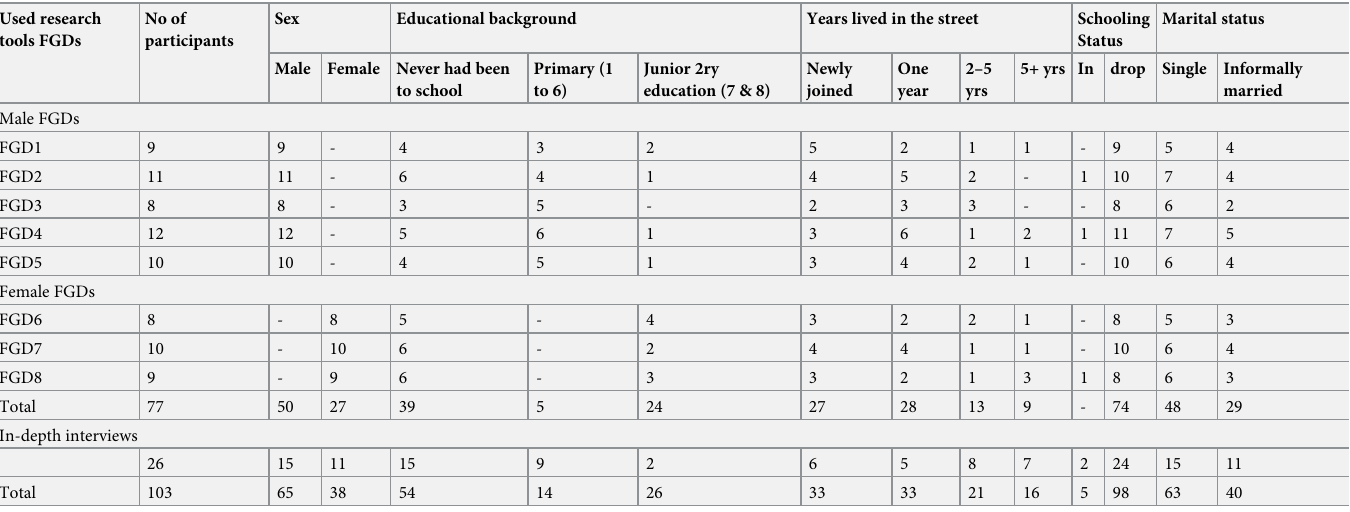
Table 1. Demographic characteristic of street children in Addis Ababa, Ethiopia 2019. Used research tools